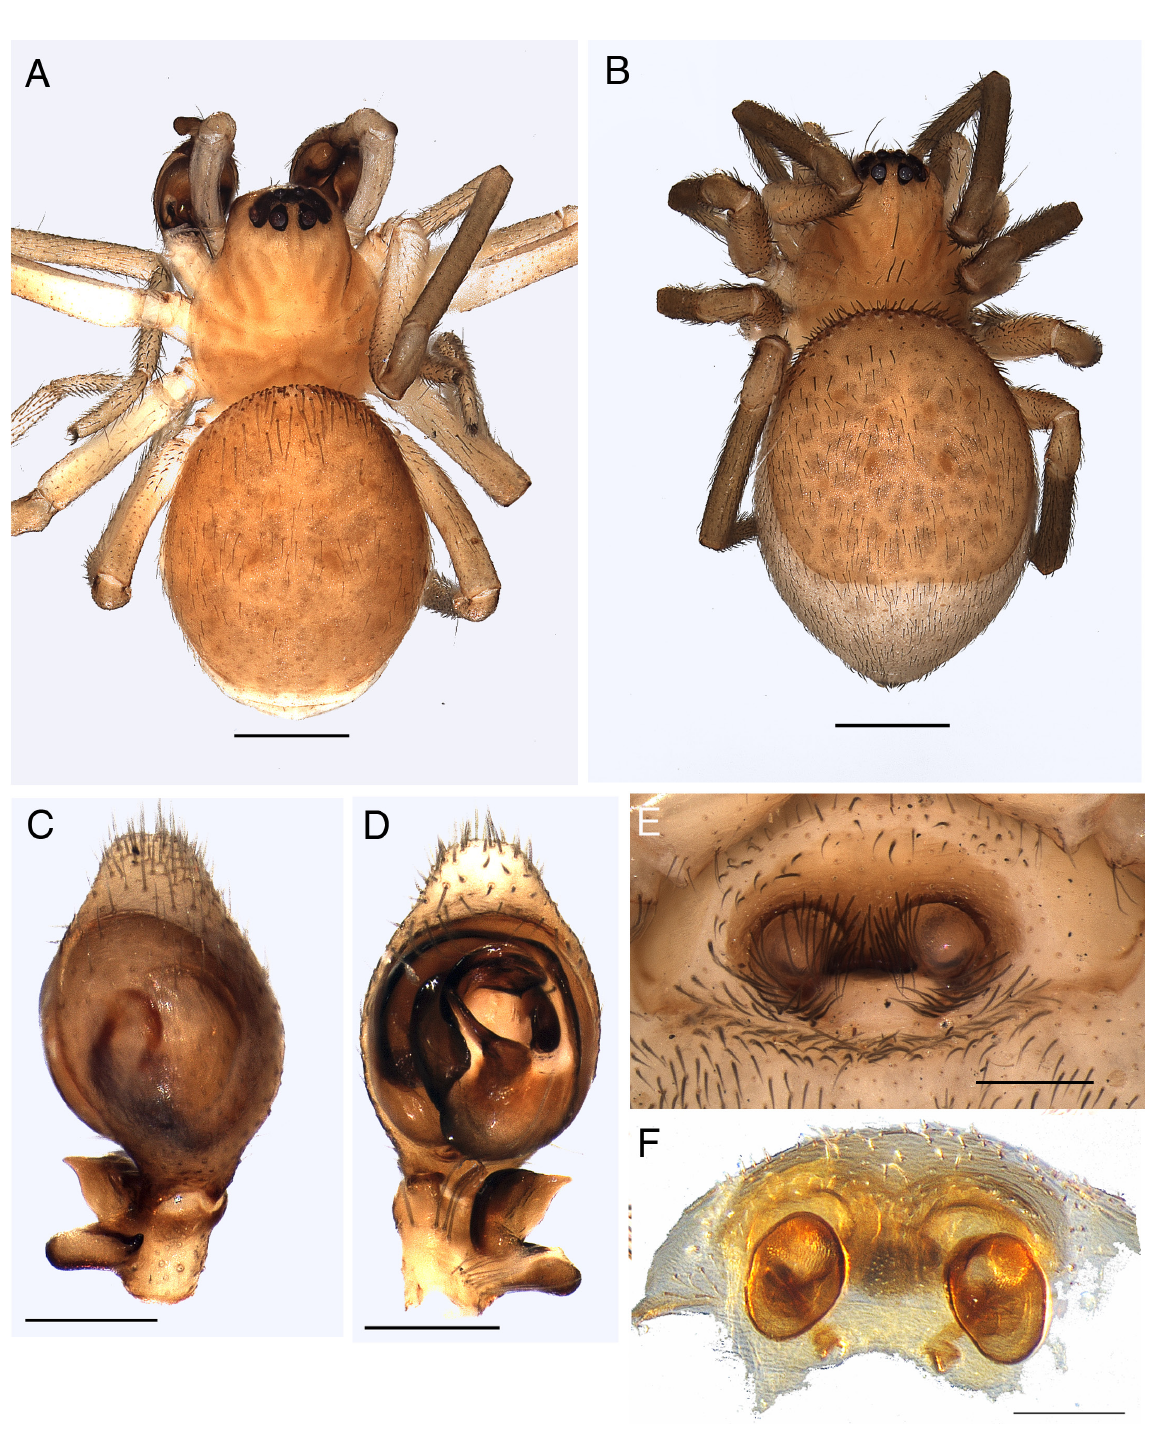
Fig. 3. Chumma foliata sp. nov. A, C–D = holotype, ♂. B, E–F = paratype, ♀. A . Habitus, dorsal view. B . Habitus, dorsal view. C . Palp, dorsal view. D . As preceding, ventral view. E . Epigyne, ventral view. F . Epigyne, cleared, dorsal view. Scale bars: A–B = 0.5 mm; C–F = 0.2